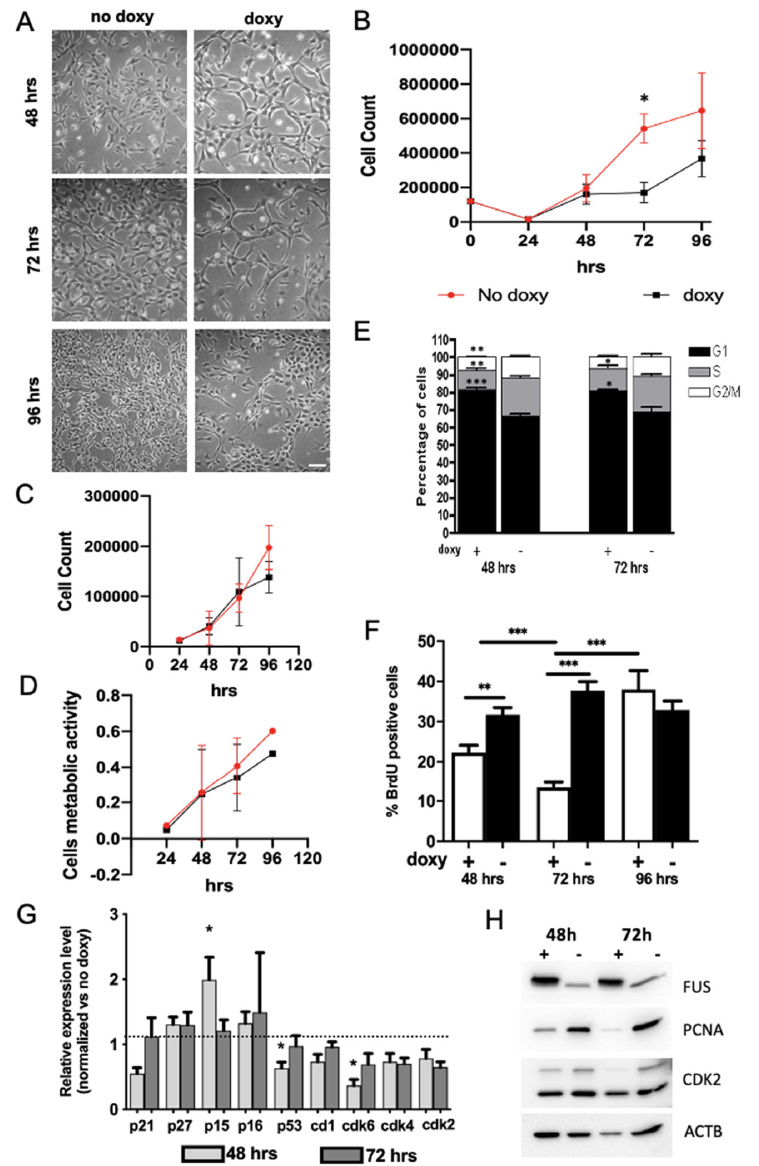
Figure 2. Expression of hWT-FUS reduces cells’ growth, inducing an arrest in G1/G0 phase in NSPCs. ( A ) Representative bright-field images of proliferating NSPCs between 48 and 96 h, showing a reduction of cell number in induced cells compared to control at 72 h. Scale bar 30 µm. ( B ) Growth curve of NSPCs expressing or not hWT-FUS between 24 and 96 h. Note that cell number significantly differs between doxycycline-treated and untreated cells. ( C , D ) Graphs show quantification of the NSPC cell death assessed by trypan blue exclusion test of viability (C) and NSPC metabolic activity, measured with MTT assay ( D ) between 48 and 96 h. ( E ) FACS analysis of proliferating NSPCs treated with or without doxycycline for 48 or 72 h. ( F ) Analysis of BrdU incorporation. The cells are stained after a pulse of 1 uM of BrdU for 20 min at the indicated time points and the number of BrdU+ cells is quantified. Nuclei are stained with Hoechst. ( G ) Graph shows qPCR of G1/G0-related gene expression levels in hWT-FUS NSPCs maintained under proliferative conditions for 48 or 72 h. Values are expressed as a fold change compared to the expression of the same genes in the uninduced cells. ( H ) Representative immunoblot of whole cell lysates obtained from NSPCs treated with or without doxycycline for 48 or 72 h. FUS protein was revealed using monoclonal anti-FUS antibody. Actin is used as a loading control. Data are presented as a mean ± SEM of 4 independent